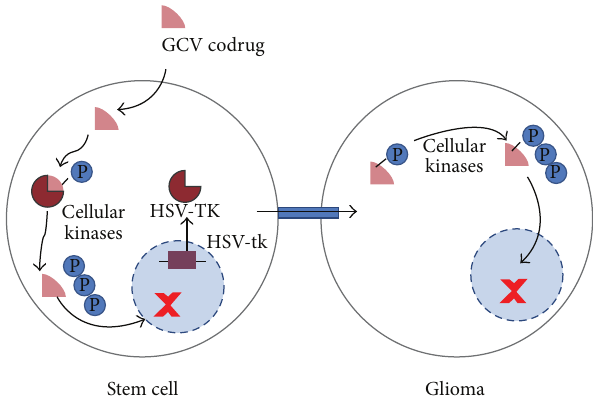
Figure1:Conceptoftumortherapybyusingsuicidegeneexpressing stem cells that are able to track tumor cells. It has been shown that certain stem cells are able to track infiltrating tumor cells [5, 14–17, 22]. In addition, the therapeutic cells must carry a suicide gene, in this case the herpes simplex virus thymidine kinase (HSV-TK). When a substrate for the HSV-TK enzyme, ganciclovir (GCV), is provided, it enters the cell and is converted by HSV- TK into GCV-monophosphate. The HSV-TK displays a 1000-fold higher affinity for GCV than the mammalian thymidine kinase so that systemic toxicity is limited while the increased affinity boosts tumor therapy capabilities [5]. Cellular kinases will phosphorylate the GCV-monophosphate further to GCV-triphosphate, a guanine nucleoside analogue which inhibits cellular DNA polymerase and results in chain termination with subsequent cell death. While this would erase the therapeutic cell but not the targeted tumor cell, a means for transferring the cytotoxic compound to the tumor cell is required. GCV-monophosphate can passively diffuse into neighboring cells after the formation of gap junctions between adjacent cells, which results mostly in tumor and therapeutic cell killing as normal adult brain cells usually do not replicate [36]. This is also known as “the bystander killing effect” [18, 37]. This approach can in theory terminate both primary and infiltrating tumor cells, thus eliminating sources of possible recurrent tumors